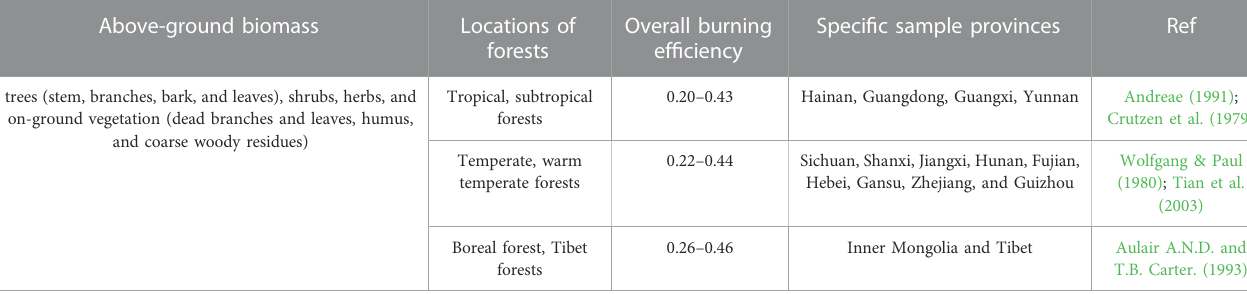
TABLE 3 The burning ef fi ciency range of different forests. Above-ground